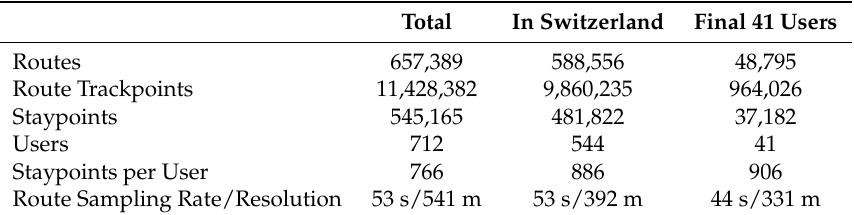
Table 2. Characteristics of the data used within this study. As the study took part in Switzerland, we restricted ourselves to track- and staypoints recorded within the bounds of Switzerland. Additionally, users were filtered to have a consistent and complete dataset, and finally a random selection of 41 users was performed to decrease computational